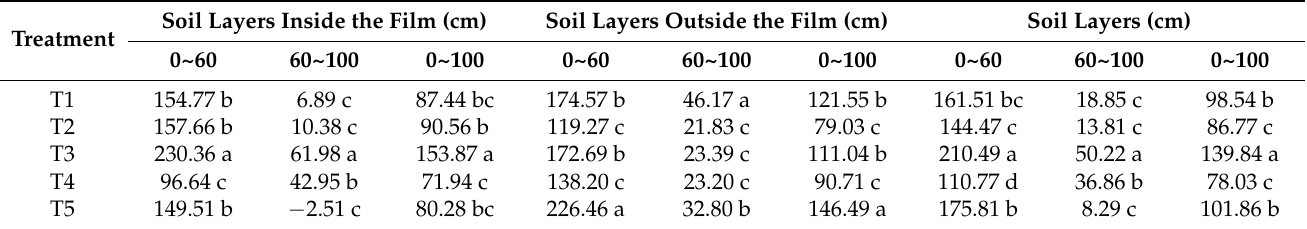
Table 3. Salt accumulation rate in different soil layers inside and outside film for treatments (%).